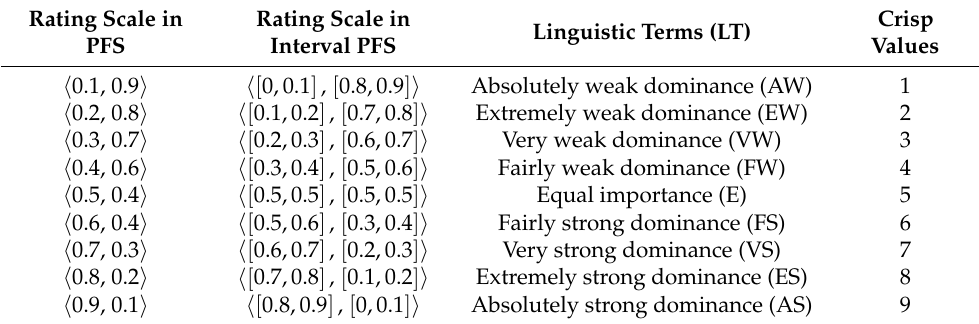
Table 2. Rating scale in PFS, Interval PFS, linguistic terms, and crisp